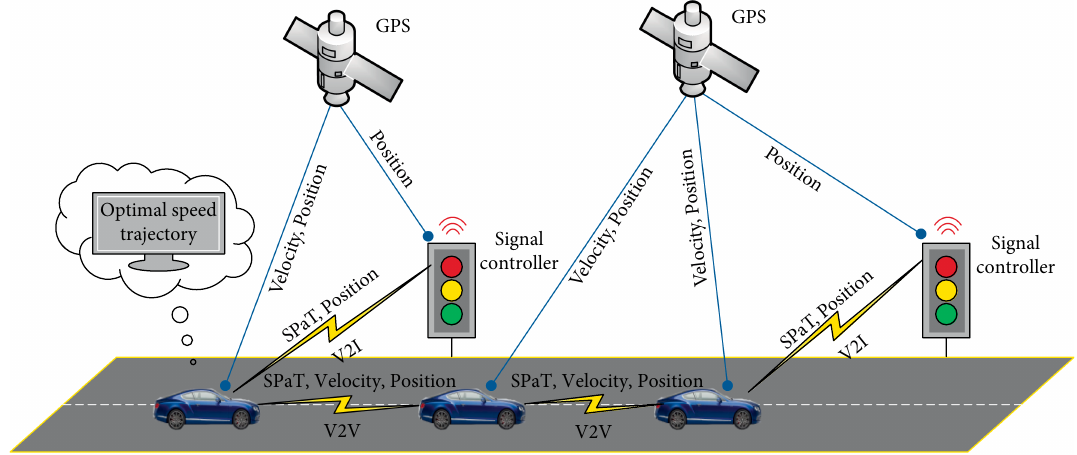
Figure 1: Communication layout of the trip.